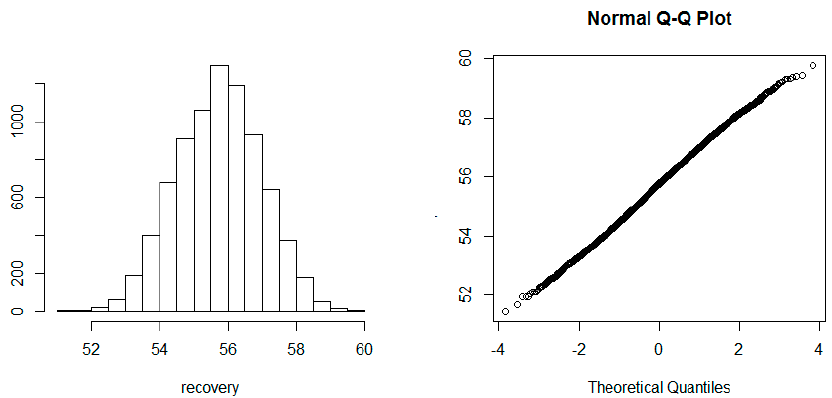
Figure 1. Uncertainty analysis at 30 days of leaching.